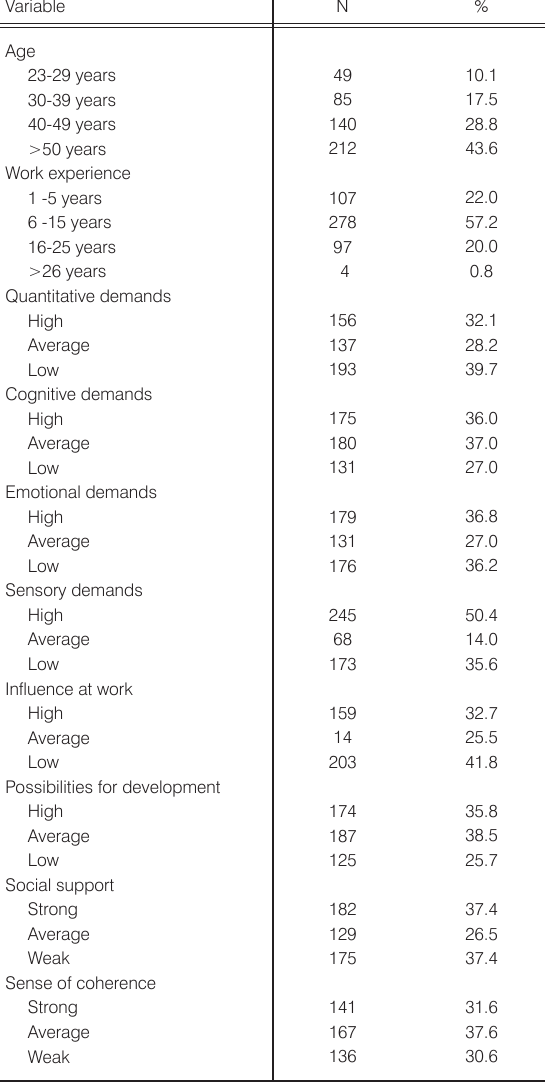
Table 2. Prevalence of the individual and psychosocial work related